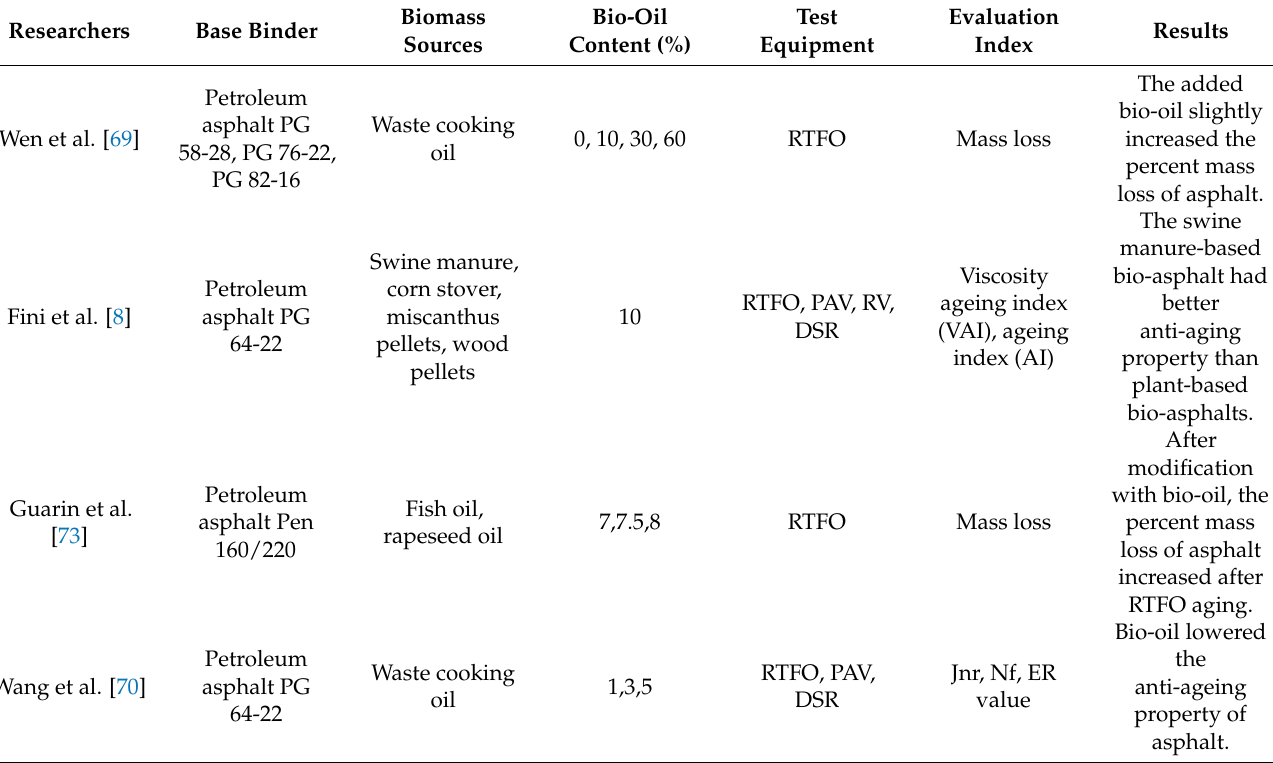
Table 8. Anti-ageing property of bio-oil modified